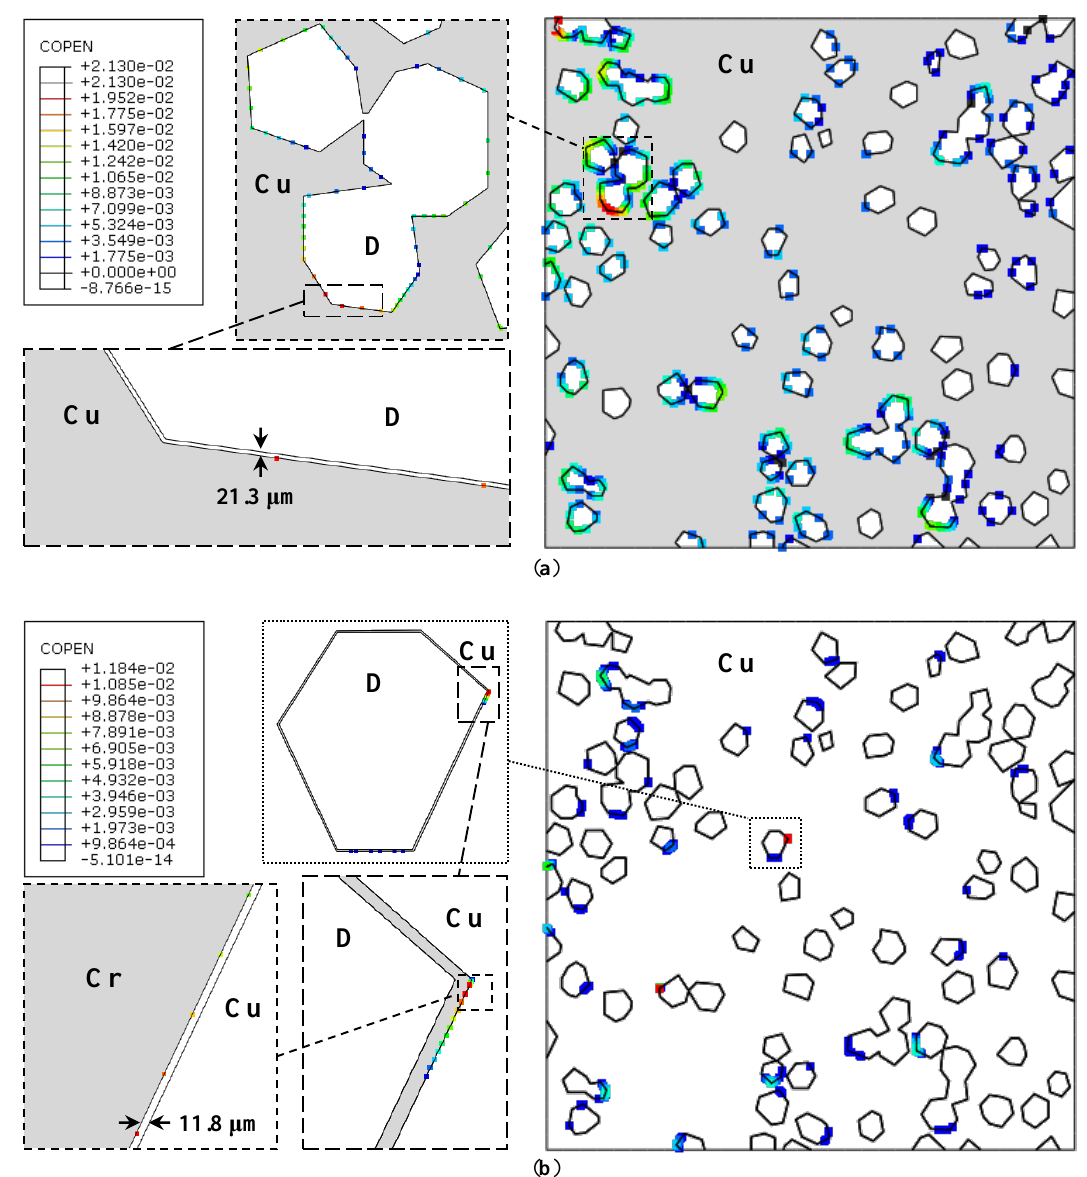
Figure 7. Contours of contact opening (mm)—( a ) Case 2: Cu/uncoated diamond; ( b ) Case 3: Cu/Cr-coated diamond.